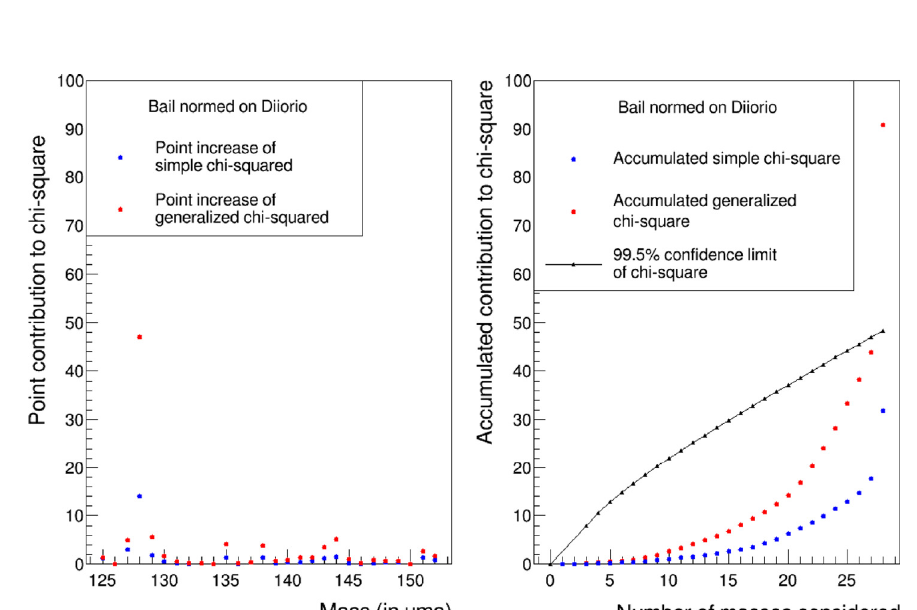
Fig. 3. Contribution to the x 2 and x 2 values for the Bail measurements compared to the Diiorio data. (left) The mass 128 corresponds g to the largest contribution to the x 2 or x 2 . For this plot, blue dots present simple x 2 calculations and red dots correspond to generalized g x 2 calculations. (right) Cumulative contributions of x 2 and x 2 as a function of the number of masses considered. Only one mass induced g g a cumulative x 2 value (red points) larger than the x 2 limit for 99.5% con fi dence level (black dots). It is clear that the second g lim calculations ( x 2 ) are expressly needed for a relevant mass test. g